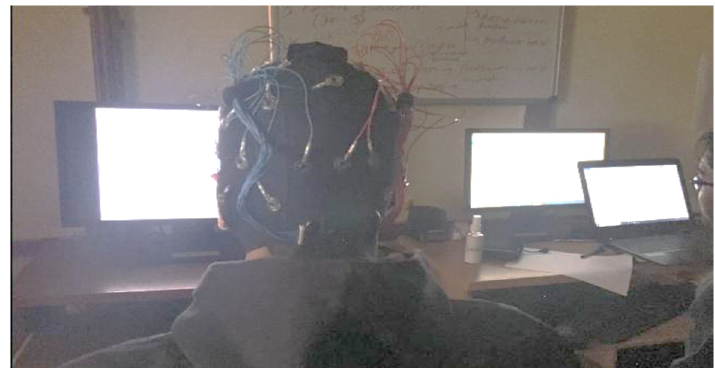
Figure 2. Experimental setup: a subject is performing the various mental tasks.